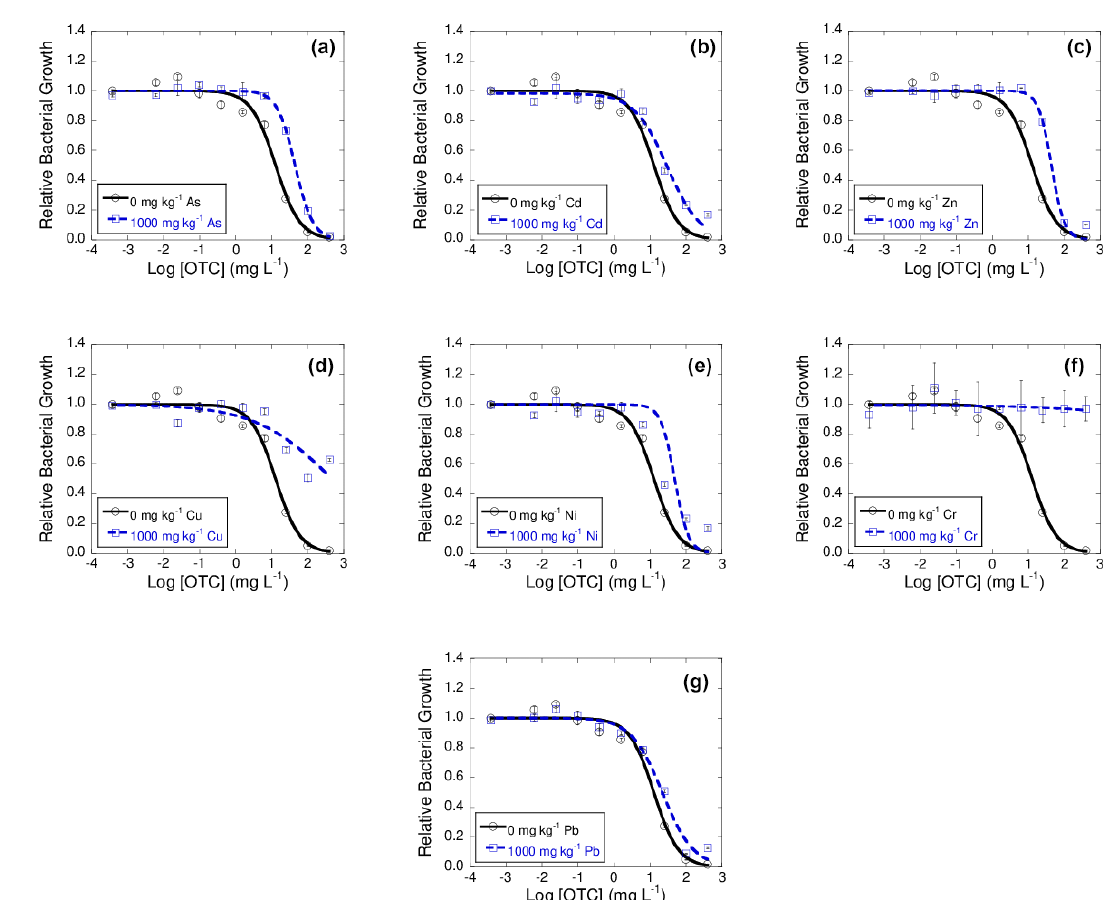
Figure 3. Dose–response curves obtained after the addition of 10 different concentration of oxytetracycline (OTC) to bacterial suspension extracted from soil samples polluted with 1000mgkg − 1 of As (a) , Cd (b) , Zn (c) , Cu (d) , Ni (e) , Cr (f) , or Pb (g) , each of them added separately, after 42d of incubation. Black lines represent the dose–response curves obtained for the unpolluted soil (control), and dashed blue lines are dose–response curves for soils polluted with 1000mgkg − 1 of one of the heavy metals. Average values ( n = 3) with coefficients of variation always <